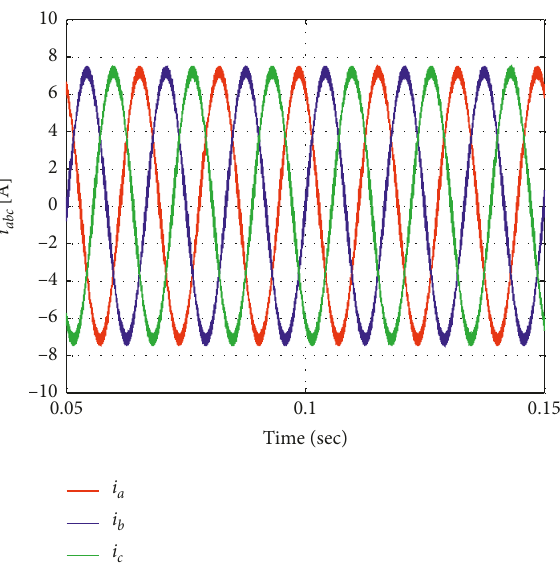
Figure 8: Steady-state grid current in CC